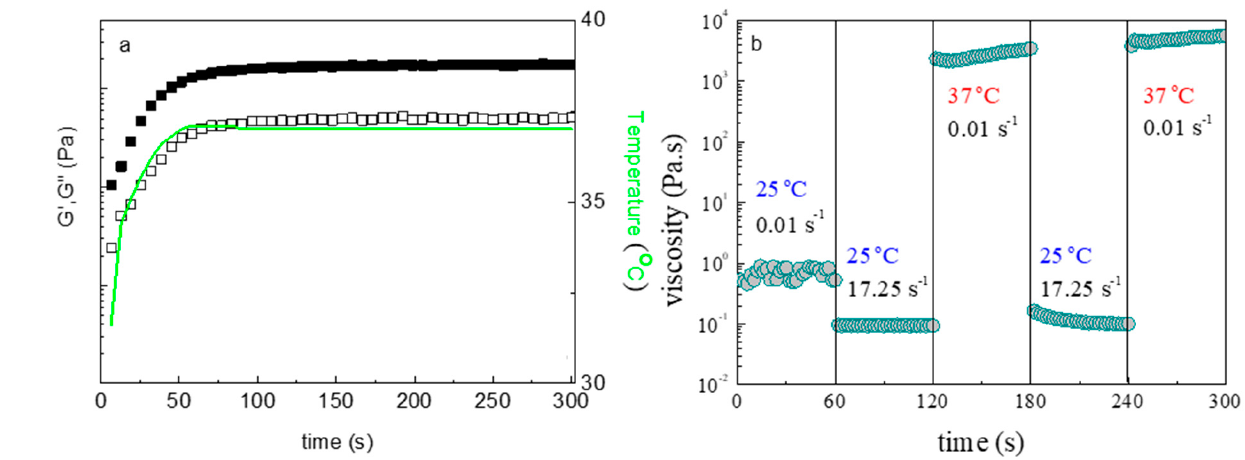
Figure 7. ( a ) Storage G ′ (closed symbols) and loss G ″ (open symbols) moduli as a function of time after temperature jump from 25 to 37 ◦ C (the green line indicates the change of temperature towards equilibration at 37 ◦ C) and ( b ) shear viscosity versus time of at different shear rates 0.01 s − 1 (at 25 ◦ C), 17.25 s − 1 (at 25 ◦ C) and 0.01 s − 1 (at 37 ◦ C) and conversely for the hNP@NaALG-g composite system (C p = 5 wt%).